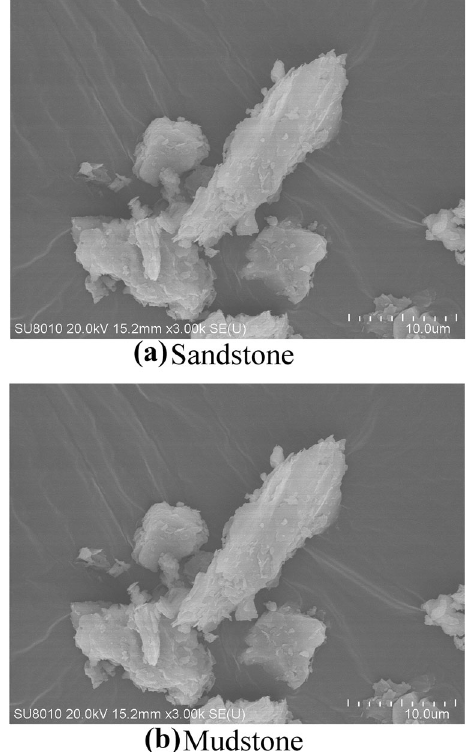
Fig. 5 SEM morphology of rock samples after simulation experiment